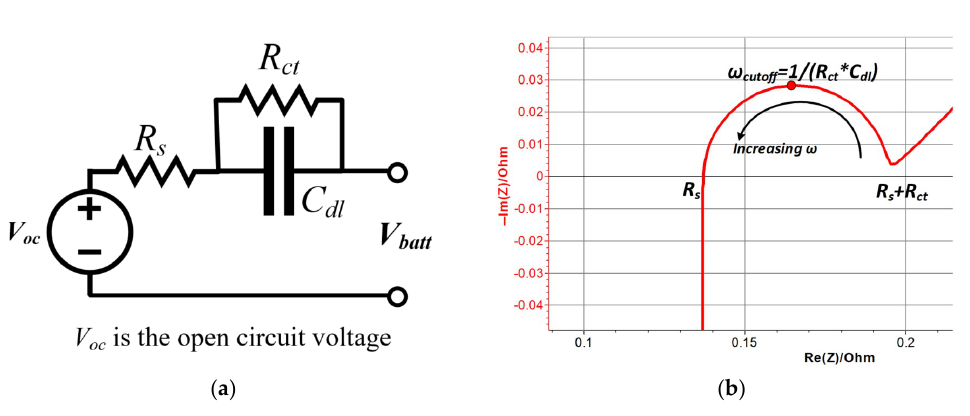
Figure 4 . ( a ) LiPo battery equivalent circuit; and ( b ) Nyquist plot. Figure 4. ( a ) LiPo battery equivalent circuit; and ( b ) Nyquist